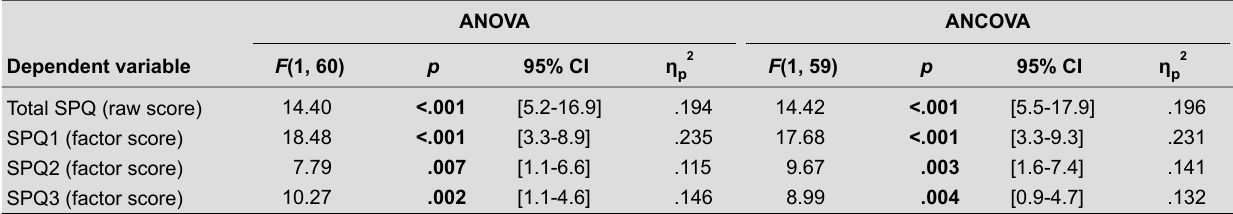
Results of Statistical Analyses of Family History on Schizotypal Personality Questionnaire Scores for Moroccan Migrants (n =